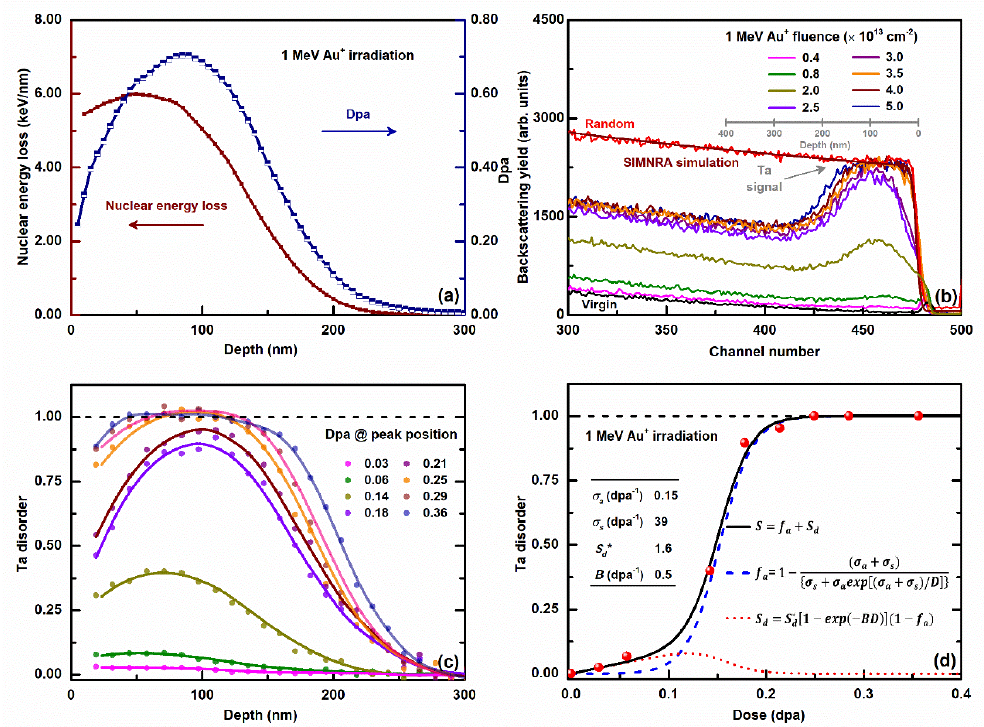
Figure 3. ( a ) SRIM-simulated nuclear energy loss and dpa profiles in Au + -irradiated LiTaO 3 corresponding to a fluence of 1 × 10 14 cm −2 . ( b ) RBS/channeling spectra of LiTaO 3 samples irradiated with Au + at different fluences. ( c ) Disorder profiles of the Ta sublattice in Au + -irradiated LiTaO 3 samples. ( d ) Relative disorder of the Ta sublattice at the damage peak versus local dose (dpa) and data fitting through the disorder accumulation model.